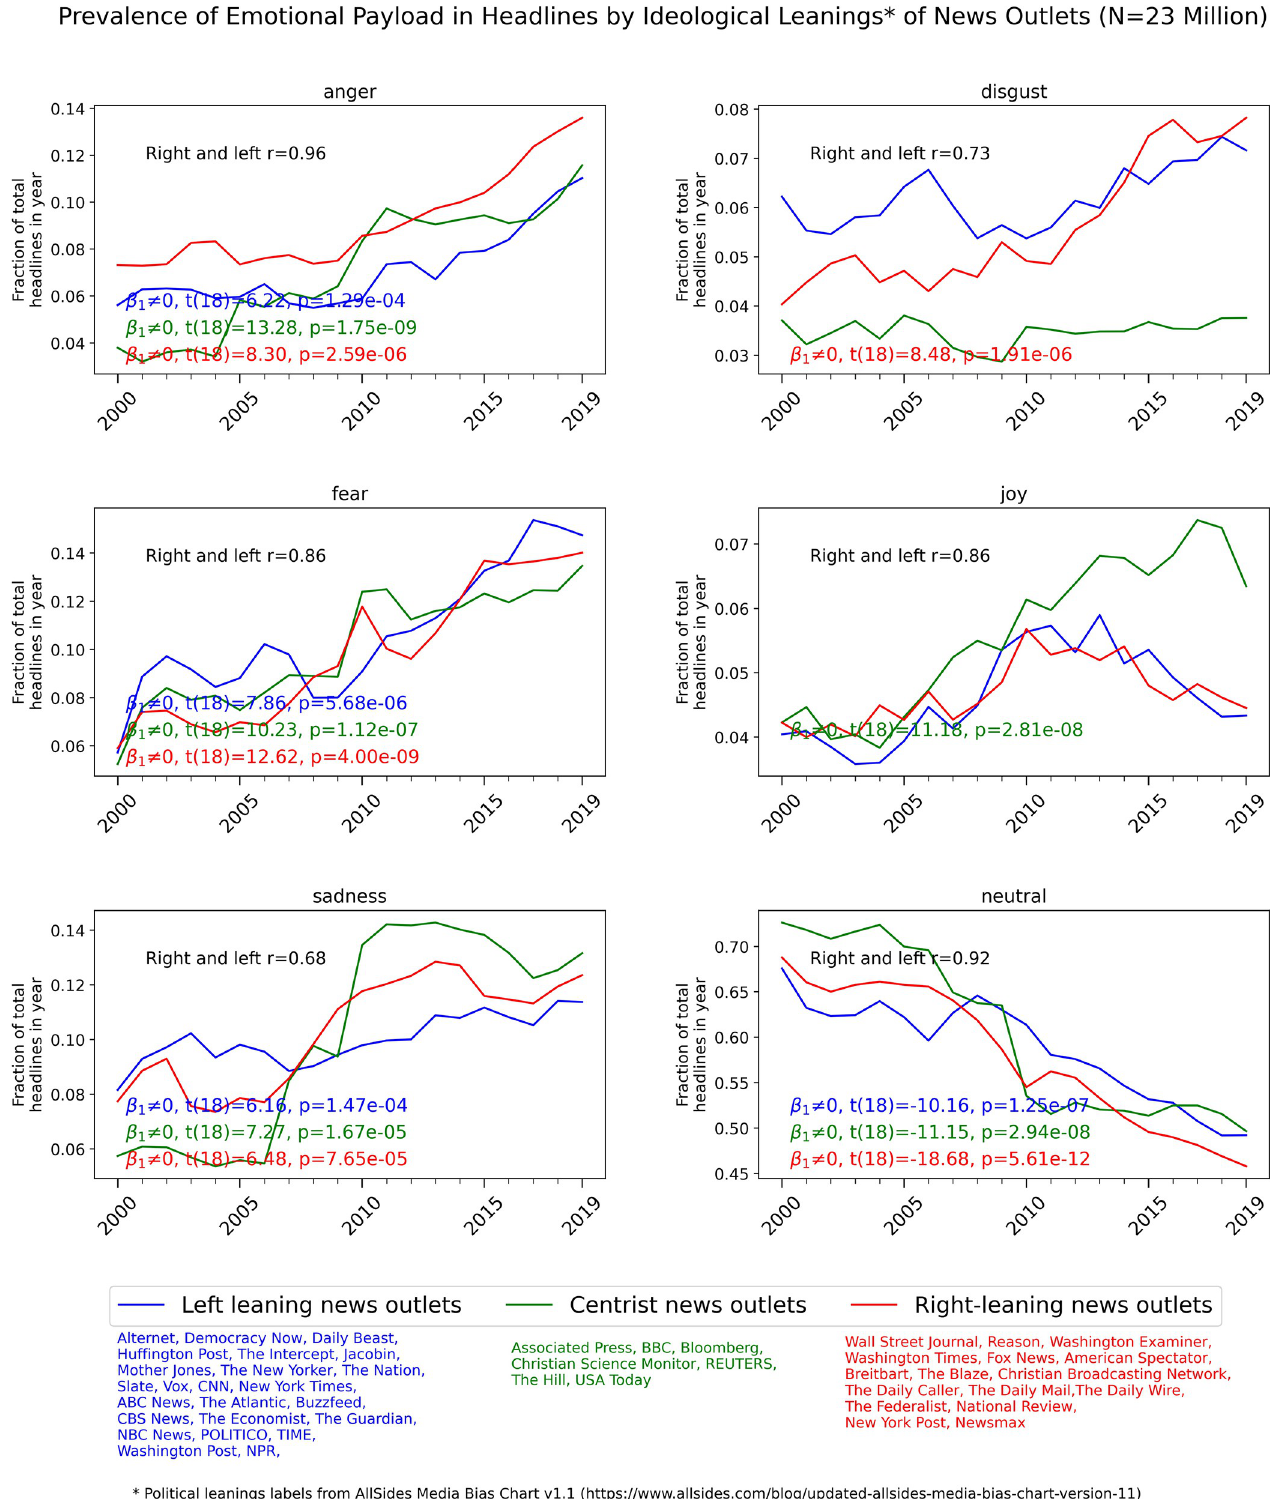
Fig 4. Yearly prevalence of headlines denoting different types of emotionality in 47 popular news outlets grouped by human ratings of news media ideological leanings from the 2019 AllSides Media Bias Chart v1.1 [24]. Note the different scale of the Y axes for the different emotion types. Only statistical tests within each ideological grouping for which the null hypothesis of zero slope was rejected (after Bonferroni correction for multiple comparisons) are shown on the bottom left of each plot. https://doi.org/10.1371/journal.pone.0276367.g004 PLOS ONE | https://doi.org/10.1371/journal.pone.0276367 October 18,